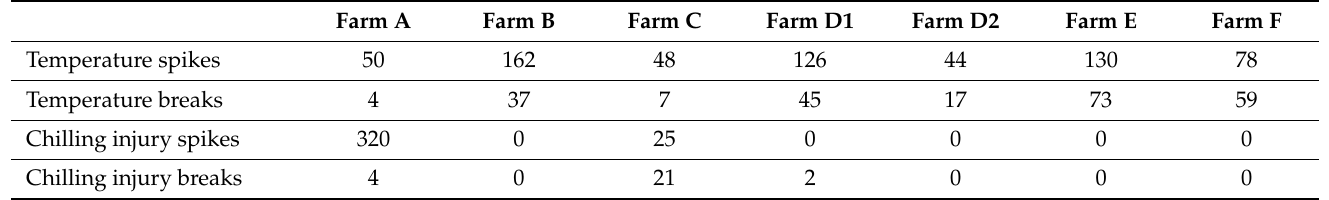
Table 3. Number of temperature and chilling injury spikes and breaks recorded per farm. Farm A Farm B Farm C Farm D1 Farm D2